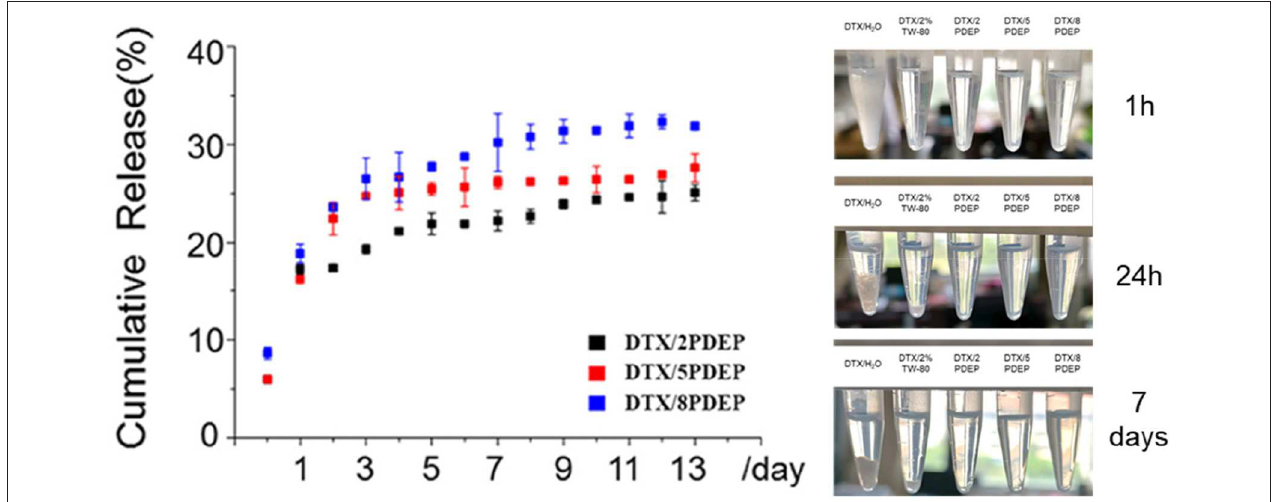
FIGURE 5 | In vitro drug release profile of DTX released from PDEP micelle-hydrogel system.